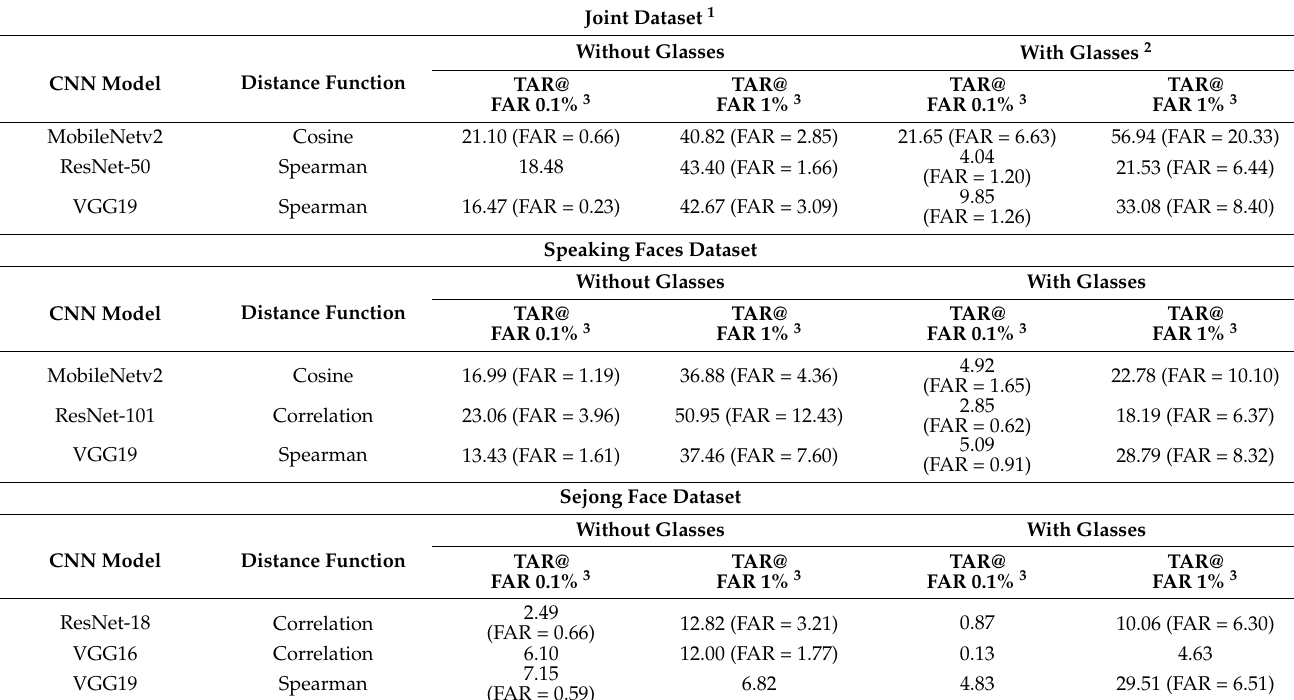
Table 3. Performance of Siamese algorithms with the joint 1 dataset, Speaking Faces dataset, and Sejong Face